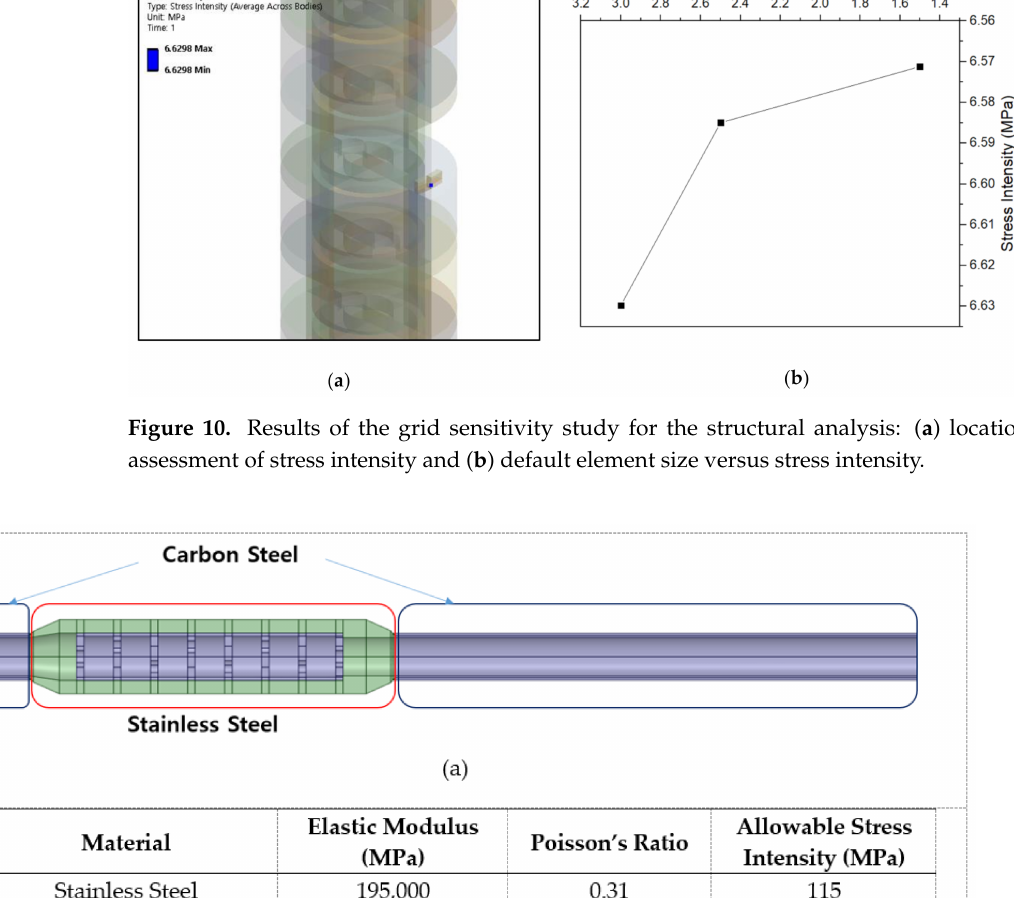
Figure 10. Results of the grid sensitivity study for the structural analysis: ( a ) location for the assessment of stress intensity and ( b ) default element size versus stress intensity. Figure 11. Material properties values per zone: ( a ) type of material properties applied per zone and ( b ) material proper- ties